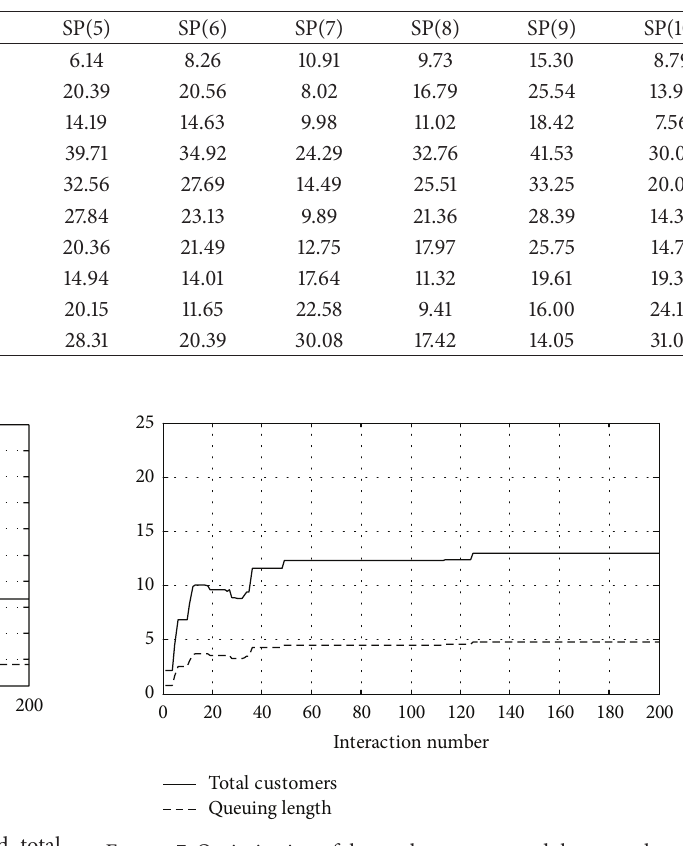
Figure 7: Optimization of the total customers and the queue